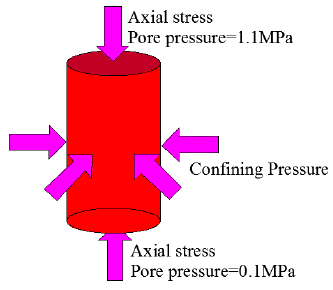
Figure 3. Stress state of a coal specimen.